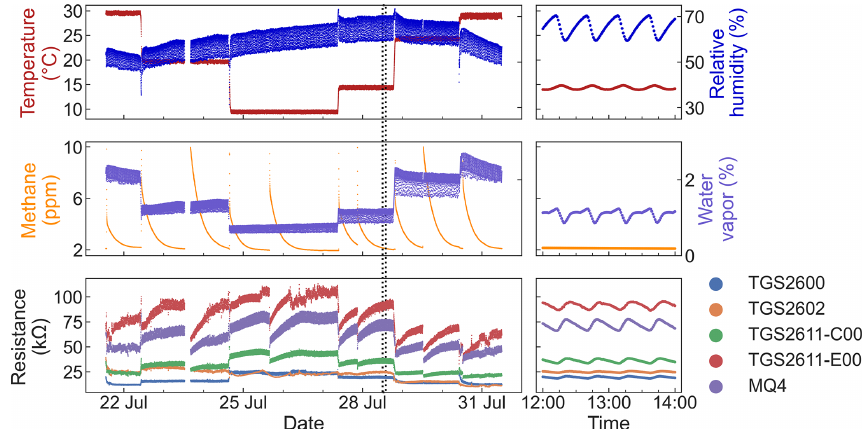
Figure 2. Time series of the full dataset. The left plots show the entire experiment; the right plots show an expanded view of the 2h inside the dotted lines. For visual clarity, only one replicate of each sensor type is